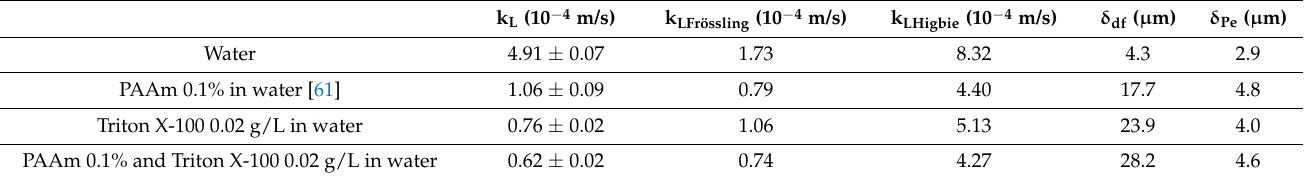
Table 3. Results for experimental k L , theoretical k L , and diffusion layer thickness. k L (10 − 4